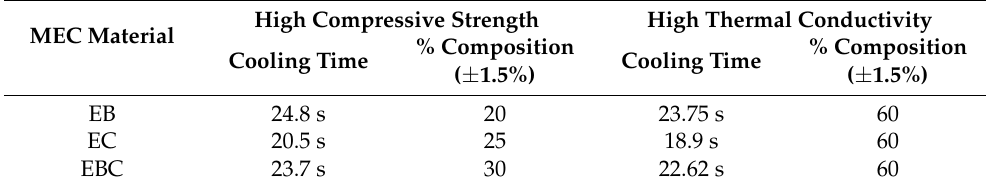
Figure 20. Transient thermal analysis at high thermal conductivity.